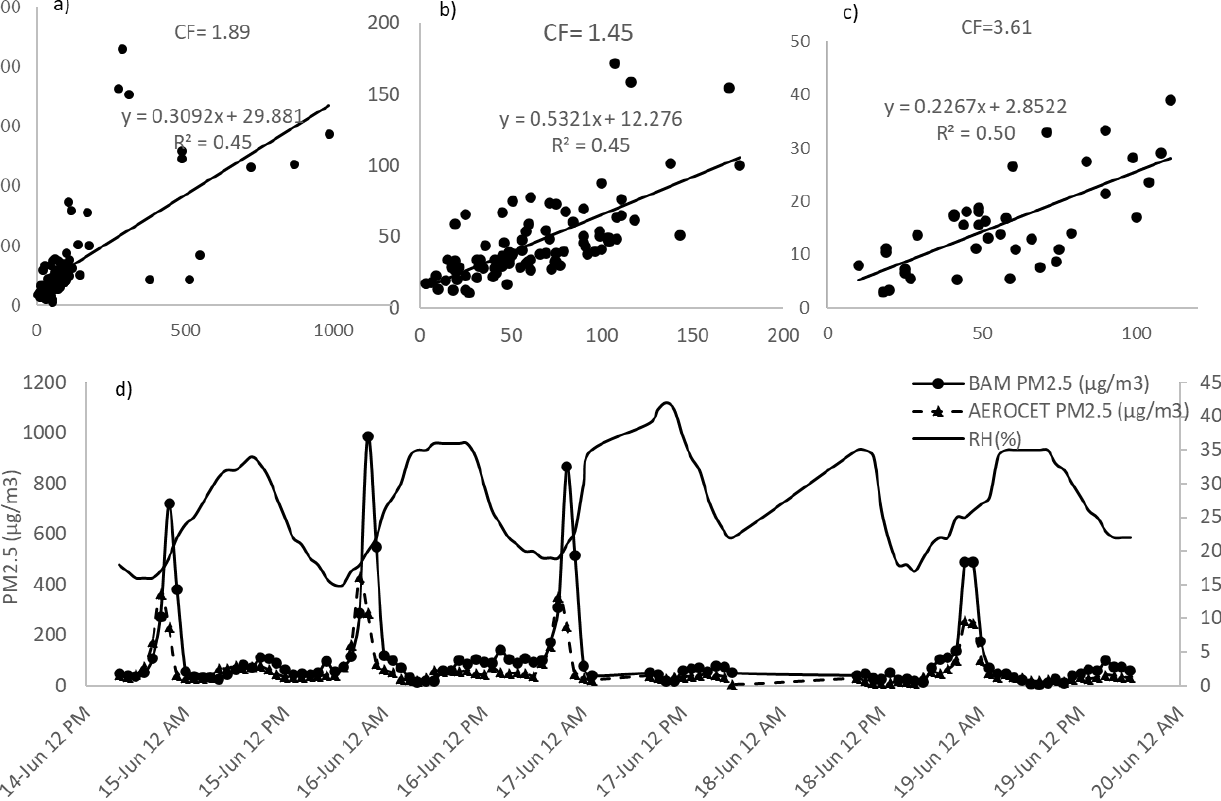
Figure 6. BAM PM 2.5 emission correlation with ( a ) AEROCET samples, ( b ) outlier removed AEROCET samples, ( c ) drone AEROCET samples, and ( d ) continuous comparison of BAM and AEROCET emission from Feedlot C along with relative humidity.